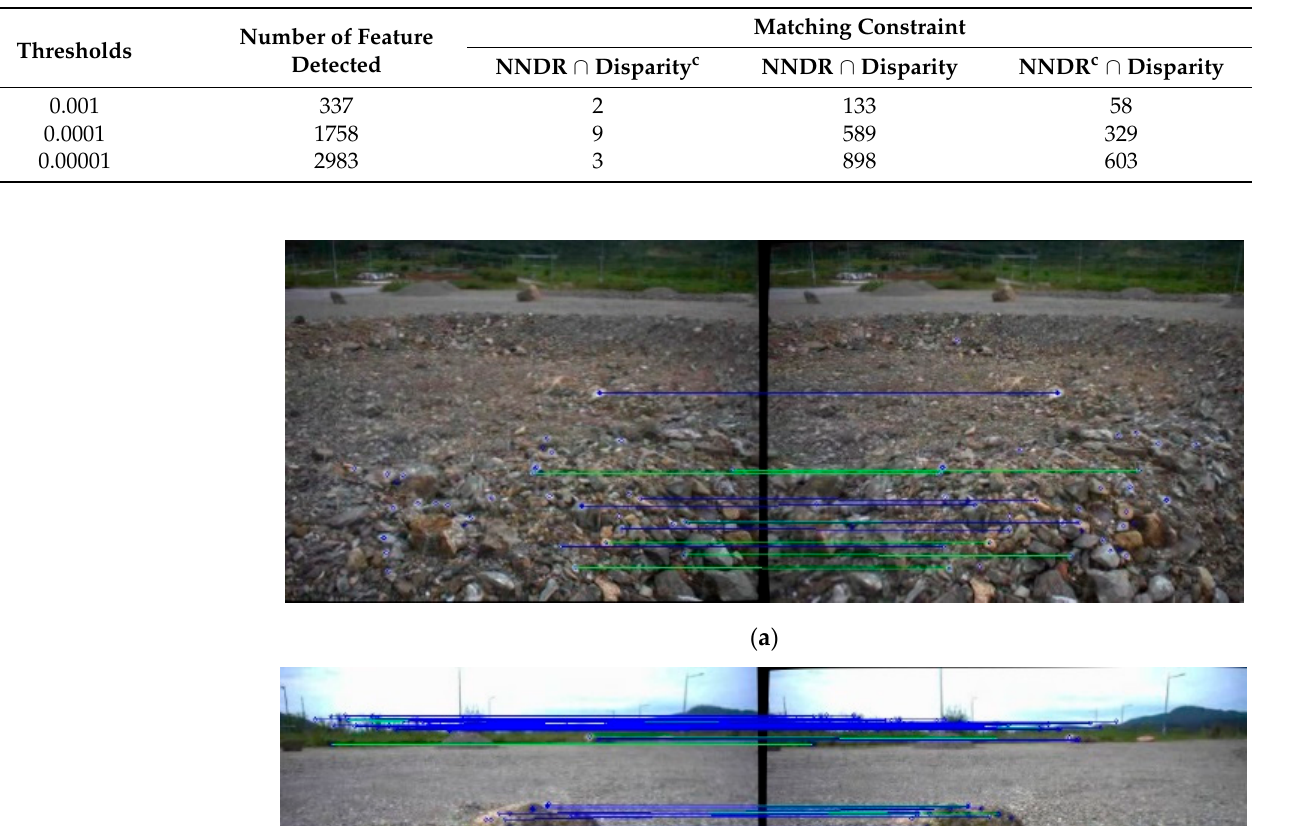
Table 1. Number of feature matches with different thresholds in AKAZE.